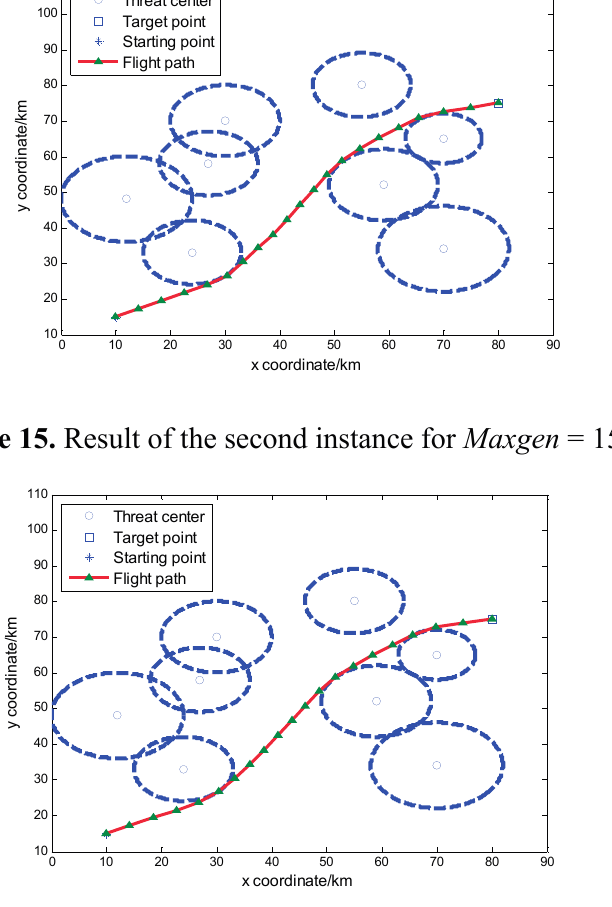
Figure 16. Result of the second instance for Maxgen =